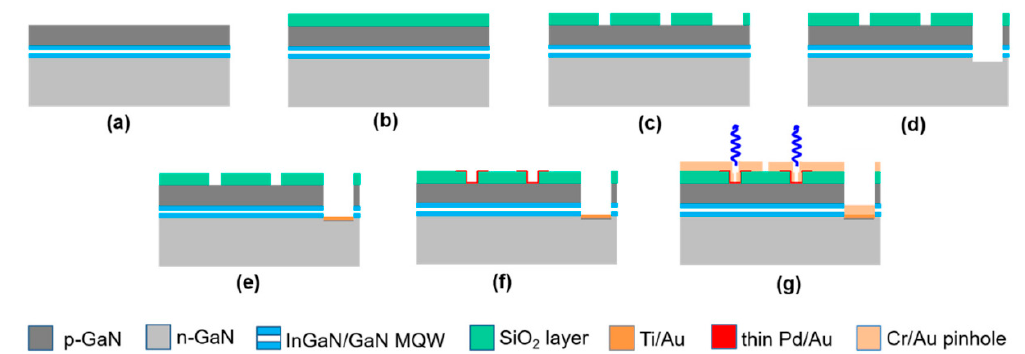
Figure 1. Fabrication process of pinhole LEDs, consisting of ( a ) preparation and cleaning of GaN ‐ based LED sample with InGaN/GaN MQW, ( b ) deposition of SiO 2 as an insulating layer, ( c ) opening of holes and contact areas on SiO 2 layer, ( d ) dry etching down to n ‐ GaN layer, ( e ) deposition of Ti/Au as n ‐ contact, ( f ) deposition of thin and semitransparent Pd/Au as p ‐ contact, ( g ) metallization of Cr/Au, subsequently defining pinhole openings, which emit blue light after